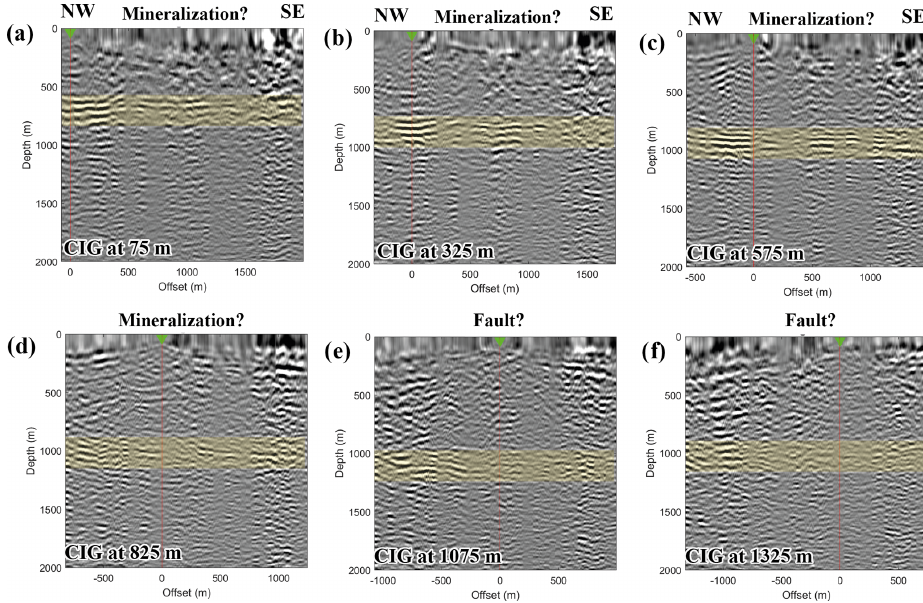
Figure 7. Six CIGs at (a) 75m, (b) 325m, (c) 575m, (d) 825m, (e) 1075m, and (f) 1325m distances along the RTM section extracted to present the quality of the RTM section (see Fig. 5). The green receiver in each CIG collocates with their CIG positions in the original image. The yellow boxes highlight where the flat events are